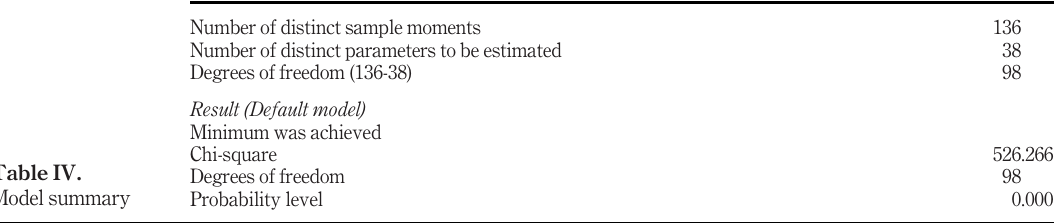
Number of distinct sample